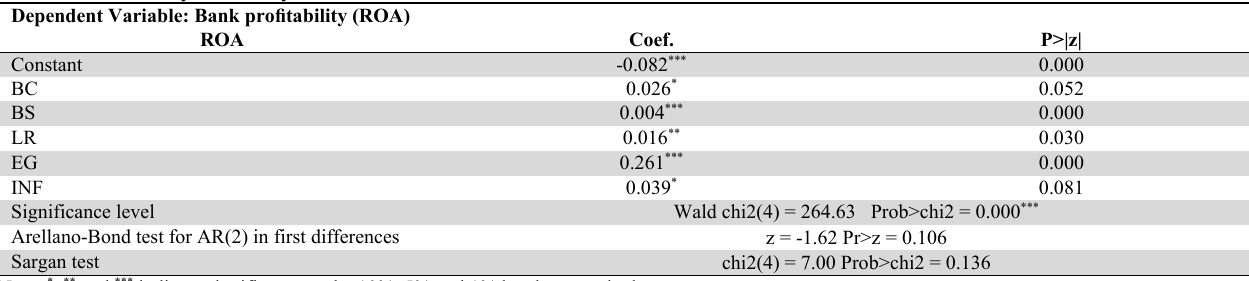
Estimation of study model by GMM method